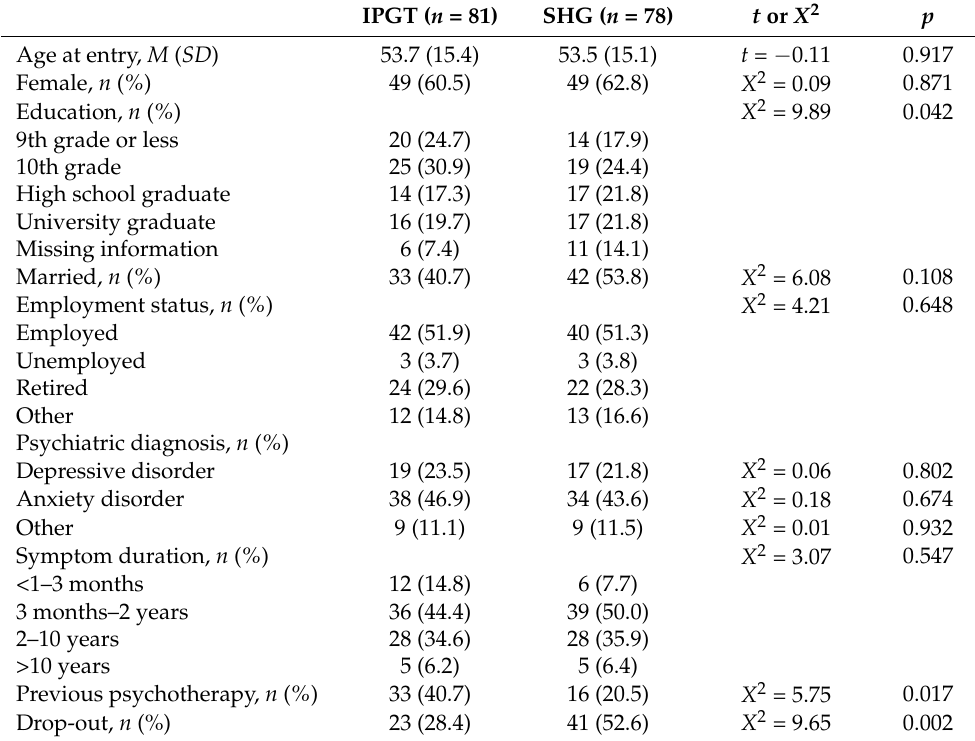
Table 1. Patient characteristics at